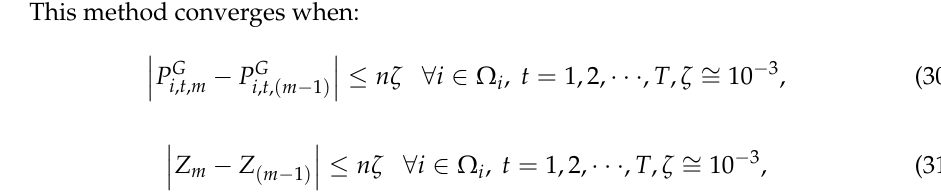
Figure 3. DC optimal power flow (DCOPF) iterative method considering system